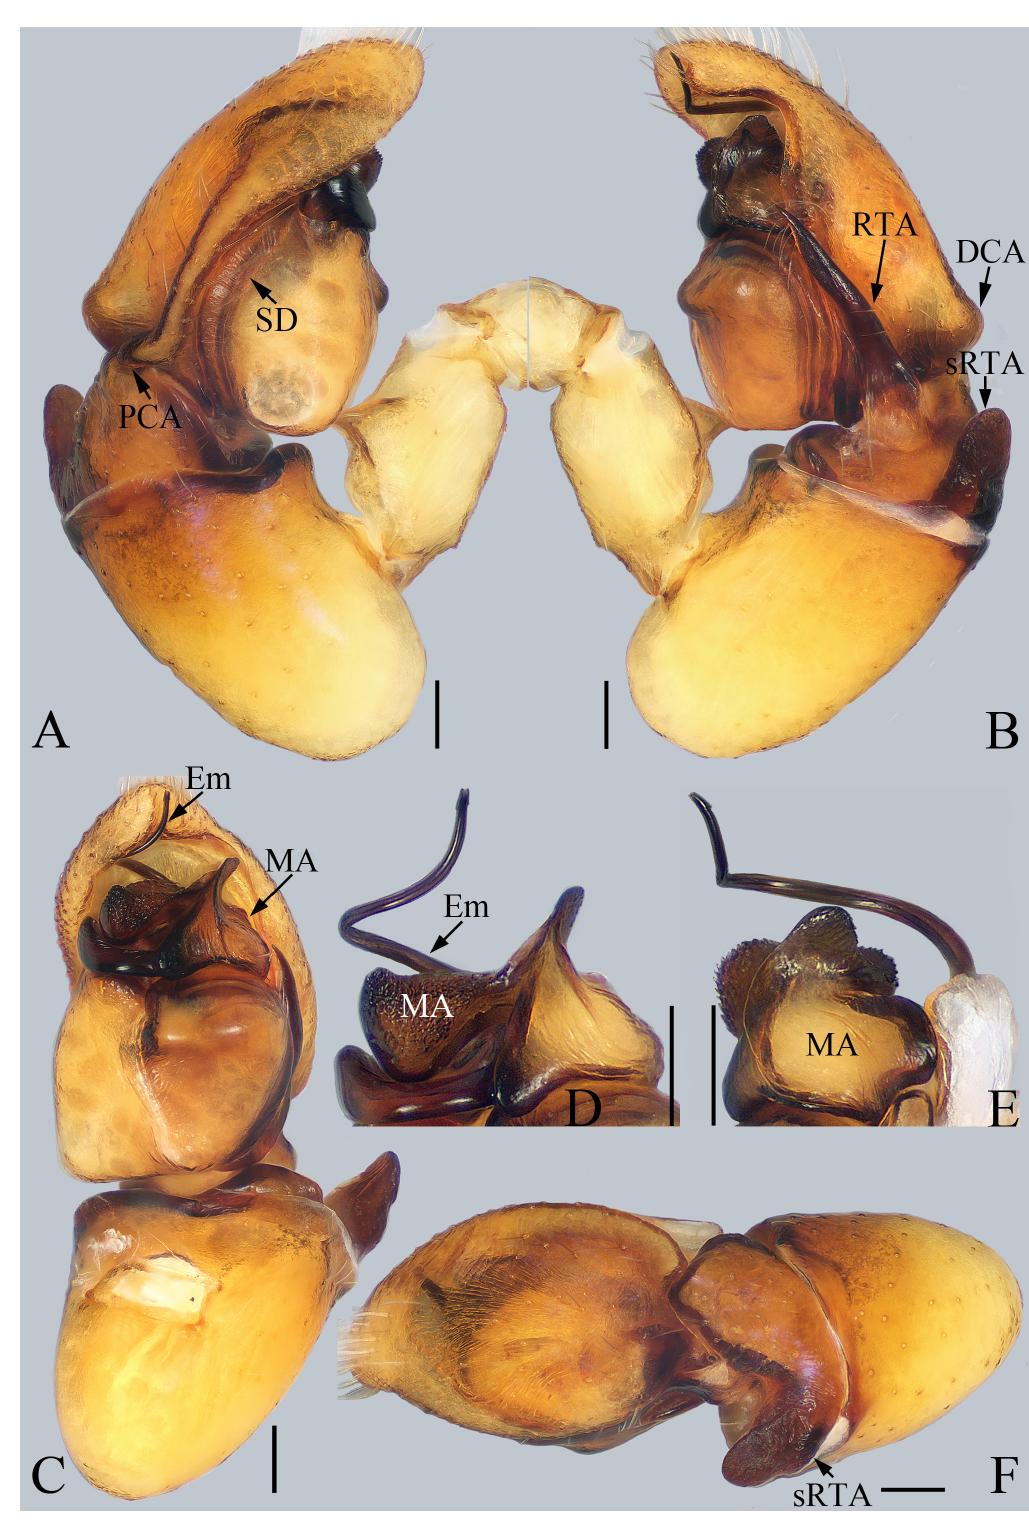
Fig. 13. Male palp of Synagelides wuliangensis sp. nov. A – C , F . Holotype, ♂ (TRU-Salticid-0044). D – E . Paratype, ♂ (TRU-Salticid-0047). A . Prolateral view. B . Retrolateral view. C . Ventral view. D . Embolus and median apophysis, ventral view. E . Embolus and median apophysis, retrolateral view. F . Dorsal view. Abbreviations: see Material and methods. Scale bars = 0.1